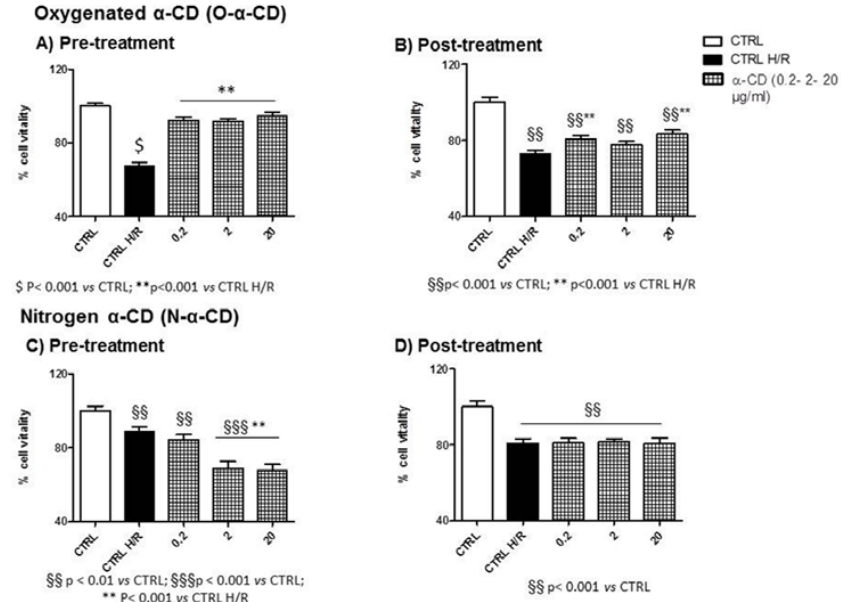
Figure 9. Cell vitality of α-CD treated H9c2 cells and H/R conditions. ( A ) Pre-treatment with O-α-CD (0.2, 2, and 20 µg/mL); ( B ) Post-treatment with O-α-CD (0.2, 2, and 20 µg/mL); ( C ) Pre-treatment with N-α-CD (0.2, 2, and 20 µg/mL); ( D ) Post-treatment with O-α-CD (0.2, 2, and 20 µg/mL), compared to the untreated control group (CTRL) and the hypoxia–reoxygenation group (CTRL H/R). Data were